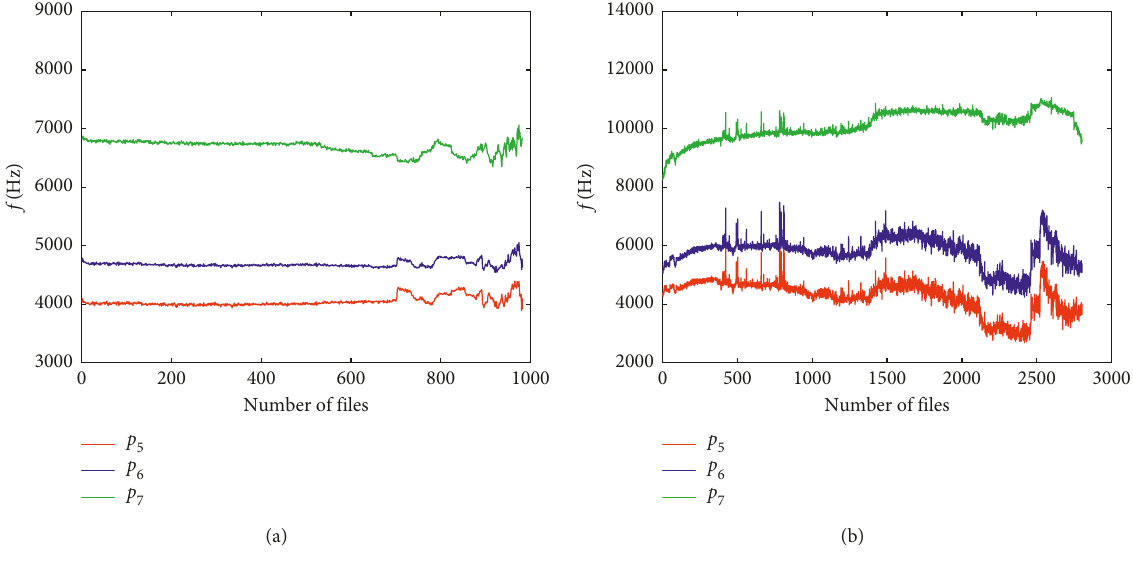
Figure 11: The p 5 , p 6 , and p 7 of (a) Case I and (b) Case